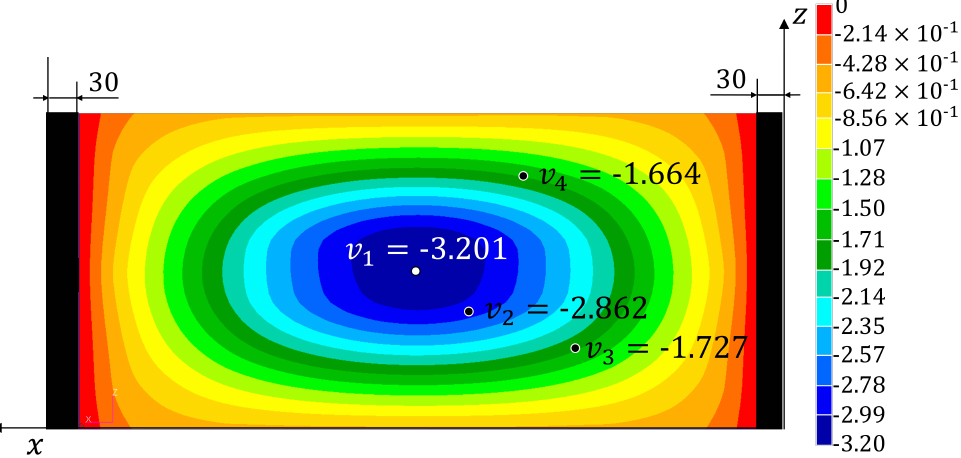
Figure 10. Test 3—Transverse displacement contour for the 2-step method with all dimensions in mm.